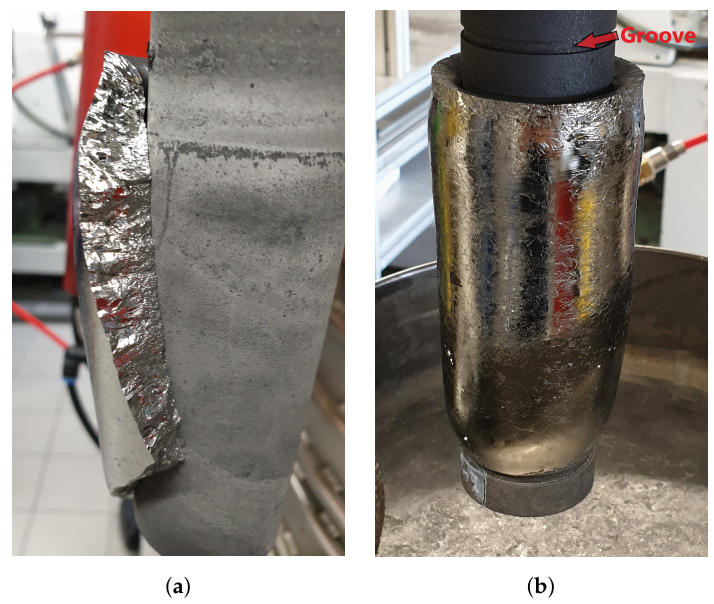
Figure 11. Influence of the graphite shell design for the attachment of the crystallized germanium. ( a ) Damaged product—flat graphite shell showing a piece of the crystallized germanium, ( b ) Fully intact product—improved graphite shell with the germanium fully attached.